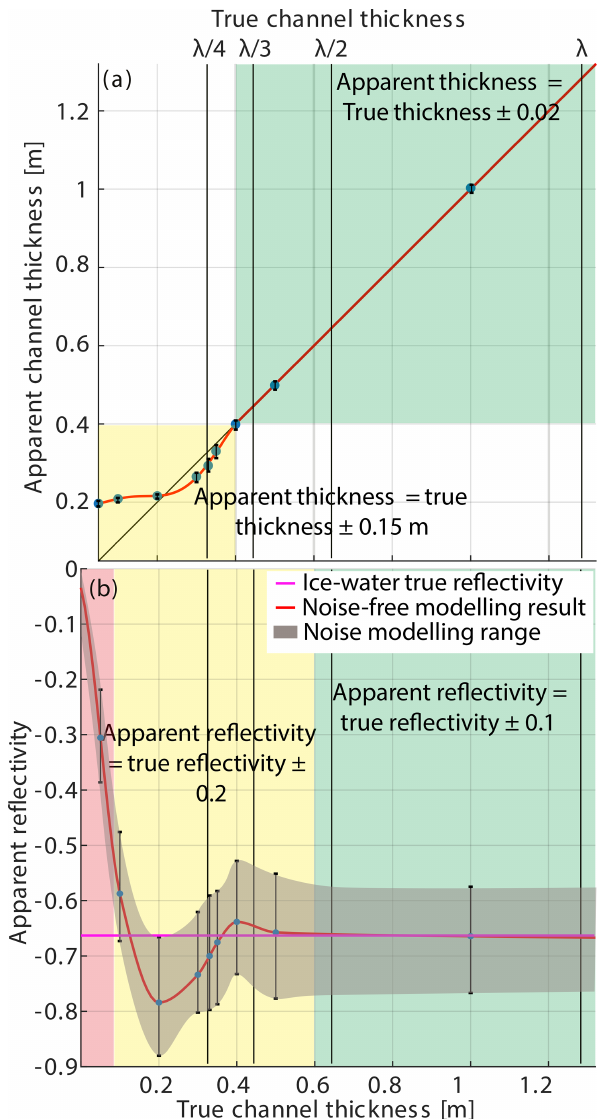
Figure 9. Forward modelling apparent thickness and reflectivity re- sults plotted against the true model conduit thickness. (a) The ap- parent thickness in the GPR inversion processing as a function of the true channel thickness in the model (Fig. 7a using 25MHz an- tennas). (b) The apparent reflectivity from the englacial conduit top as a function of the true channel thickness. The error bars represent the 2 standard deviations around 48 different noise records added to the synthetic.